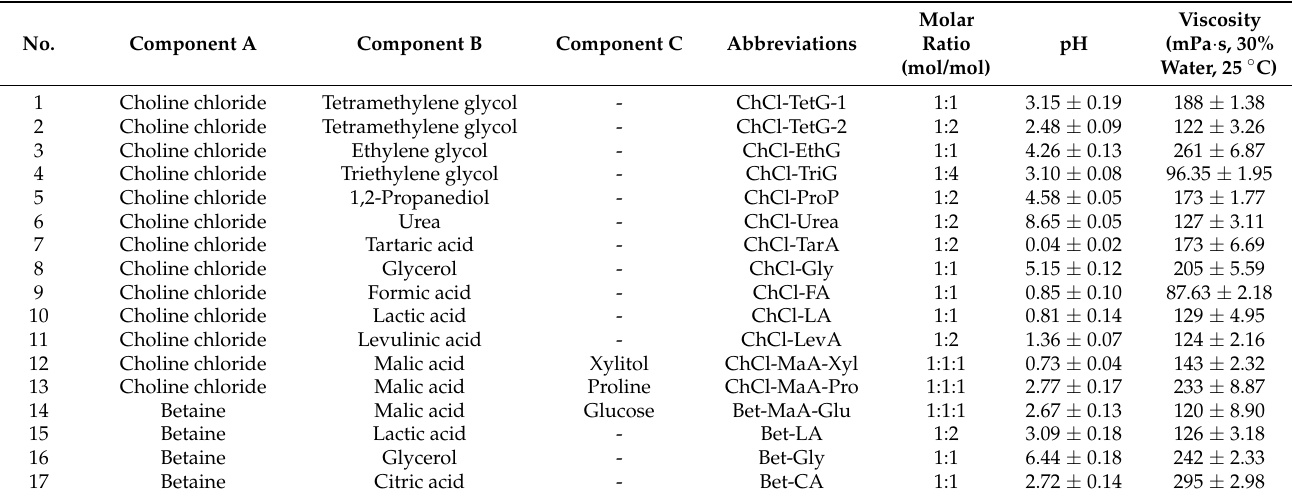
Table 1. Lists and physical-chemical properties of deep eutectic solvent (DES) prepared in this study.